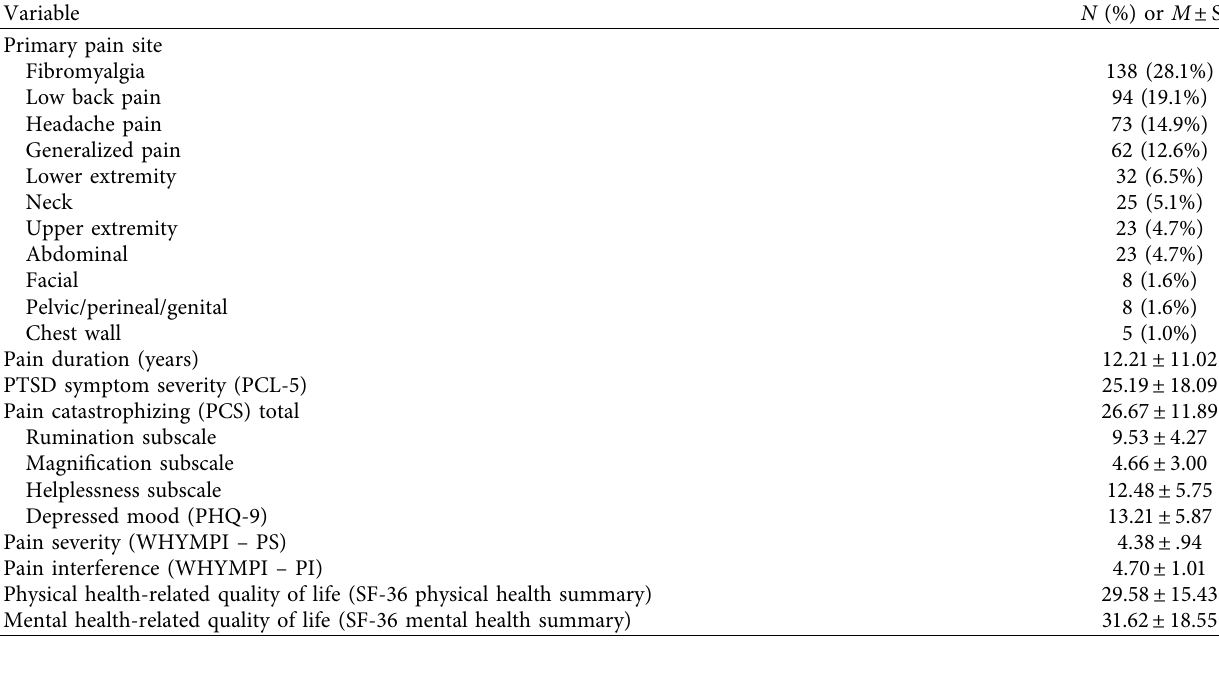
Table 2: Clinical characteristics ( N � 491).